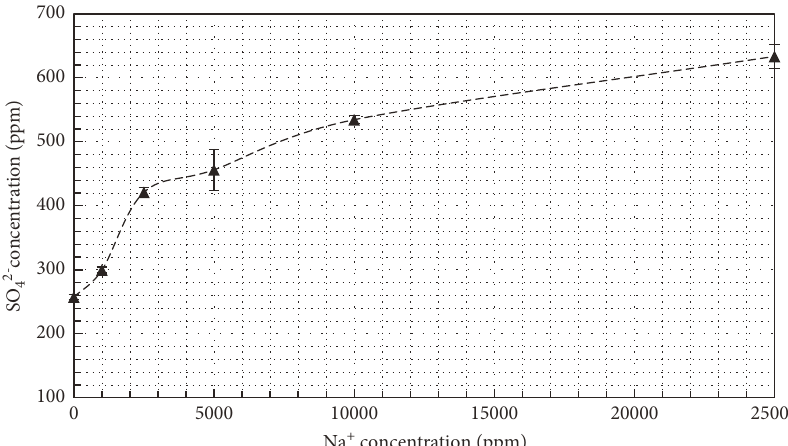
Figure 4: Effects of different concentrations of Na + ions on the sulfate concentration in treated NaCl solutions by the ettringite method. The initial sulfate concentration is 4,290ppm, and the added chemical dosage of Al :Ca: S is at a molar ratio of 2 :6:1. The RSD of sulfate concentration is less than